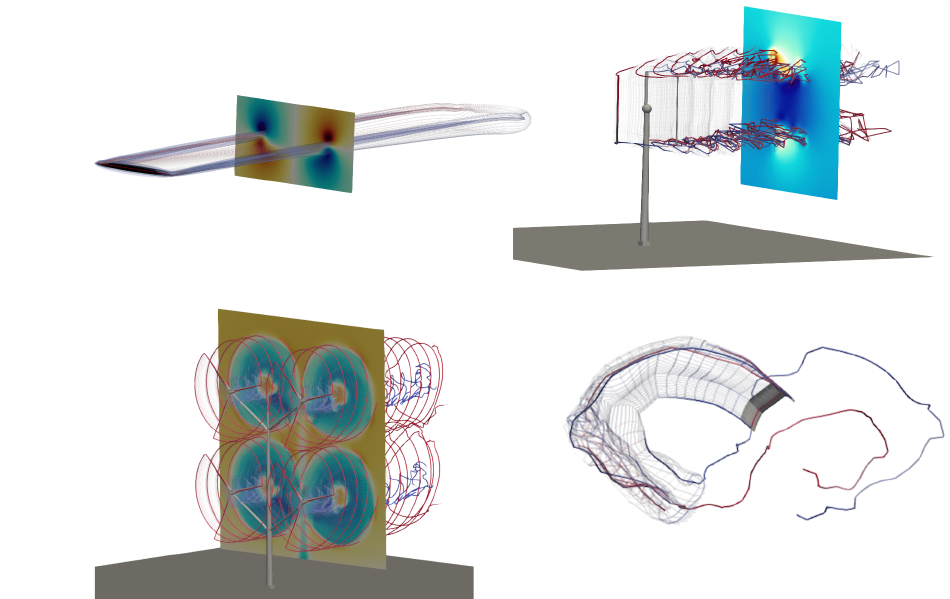
Figure 2. Example of wind energy concepts to which the AeroDyn driver may be applied – (clockwise from top left) elliptical wing, VAWT, kites, and multiple